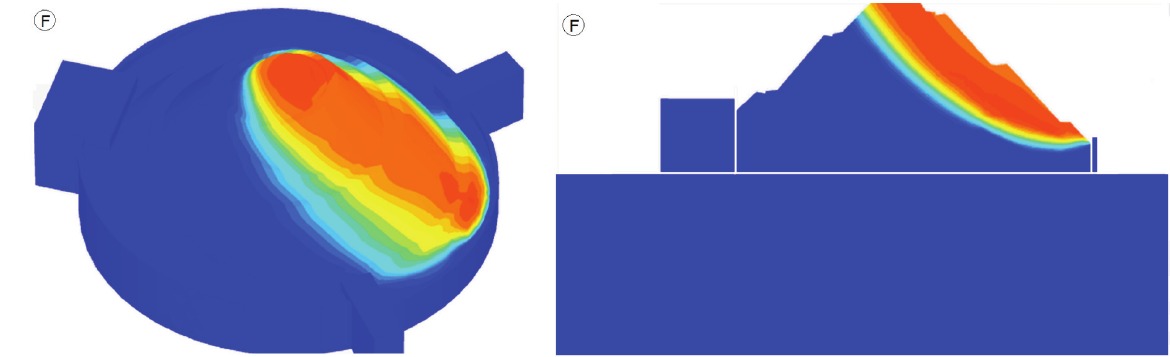
Fig. 9. Scope of slip area in the case of non-irrigated mound